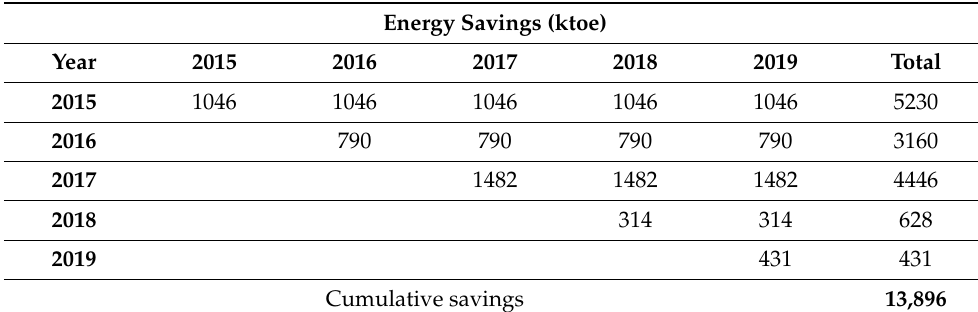
Table 3. For the years 2015–2019, energy savings (ktoe) communicated to the Italian competent authority by companies’ subject to energy audit